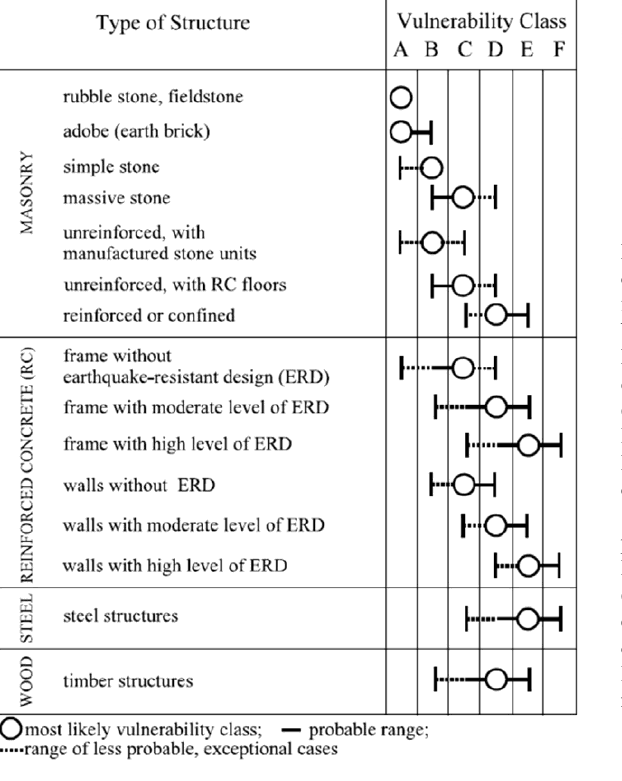
Figure 1. Vulnerability classes of EMS-98.